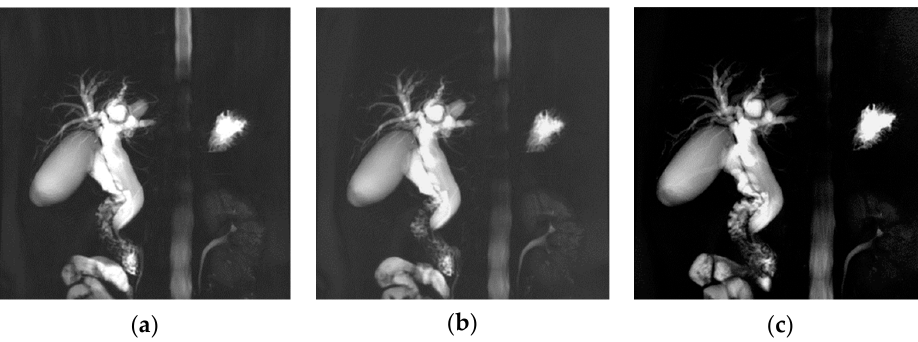
Figure 7. Patient with Common bile duct dilatation. MRCP MIP images obtained with RT-2D-CS TSE sequence ( a ), RT-2D-SENSE TSE sequence ( b ), and BH-2D-SSh TSE sequence ( c ) images.